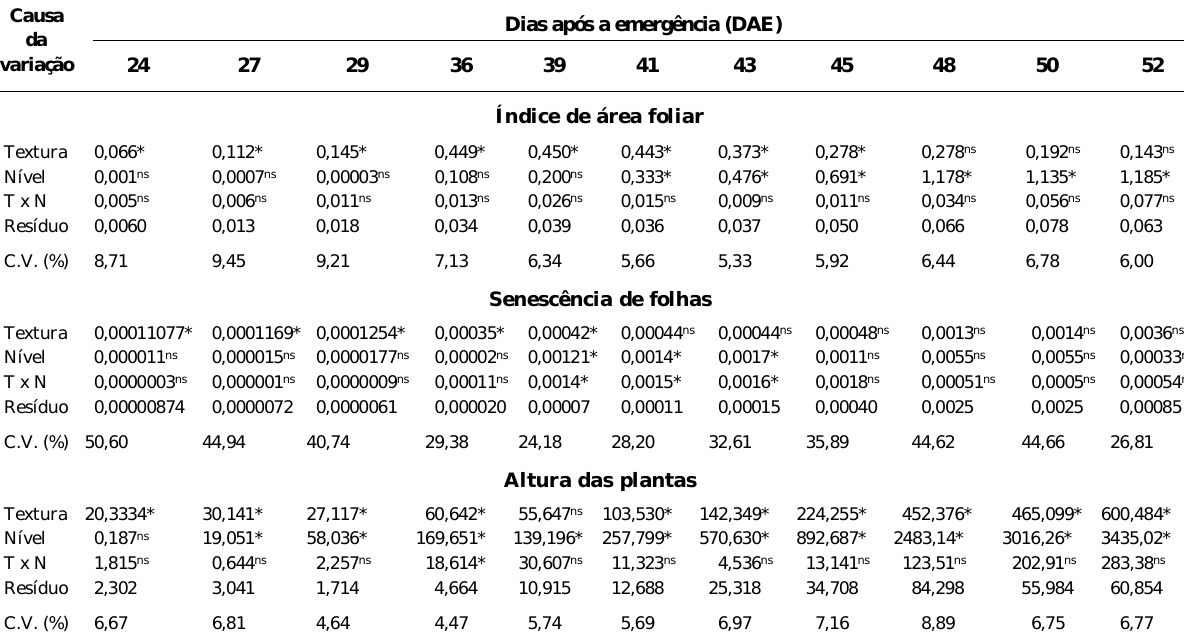
Quadro 1. Resultados do quadrado médio da análise da variância para o índice de área foliar, senescência